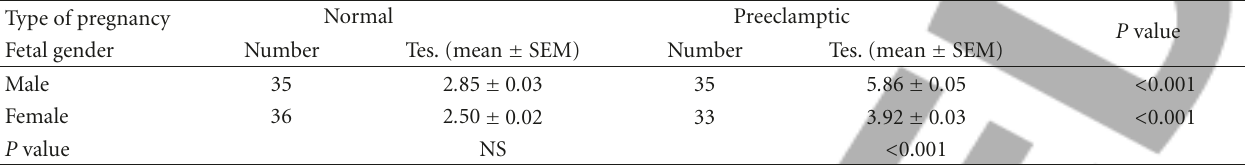
Table 3: Comparison of mean serum testosterone level in normal and preeclamptic pregnancies with male and female fetuses.